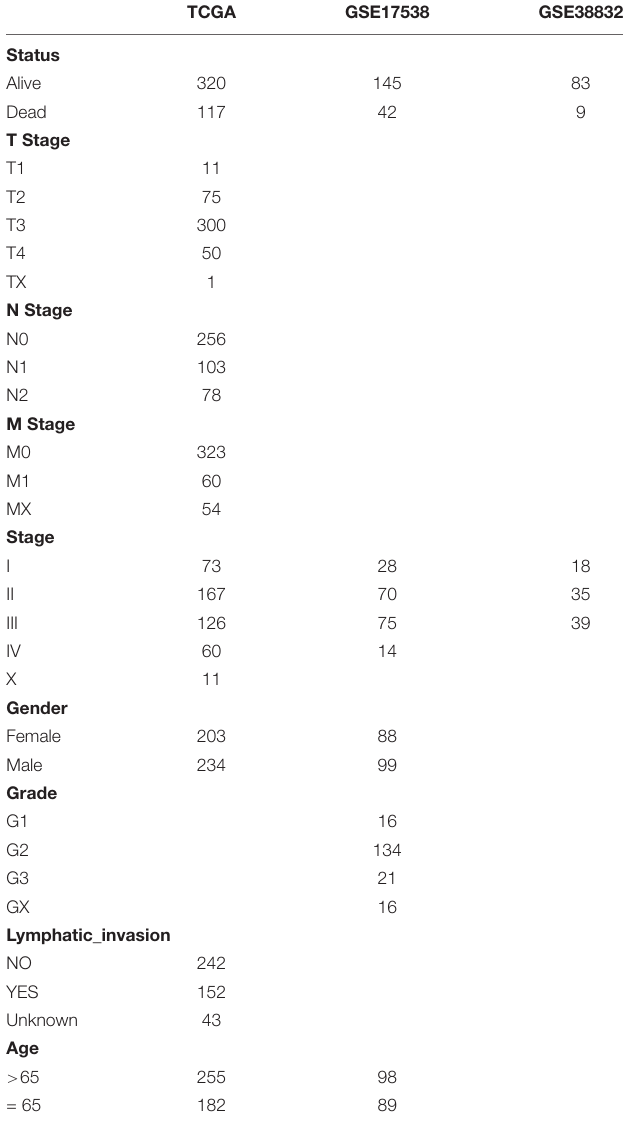
TABLE 1 | Clinical information of three